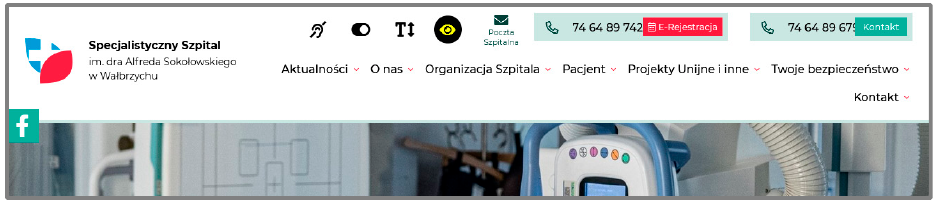
Figure 4. A piece of a website with tools for changing font size and contrast. Source: website of Alfred Sokołowski Specialist Hospital in Wa ł brzych.